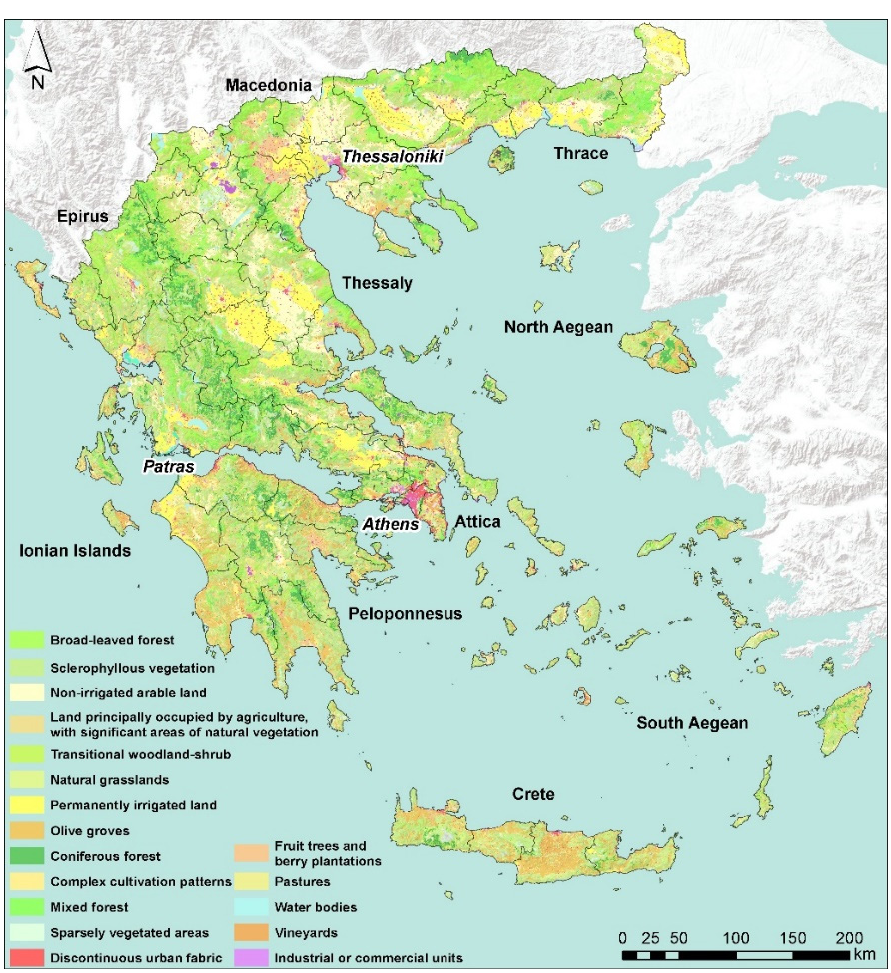
Figure 1. Main regions and urban centers of Greece. Colors describe the dominant land cover types as defined in the Corine 2018 layer